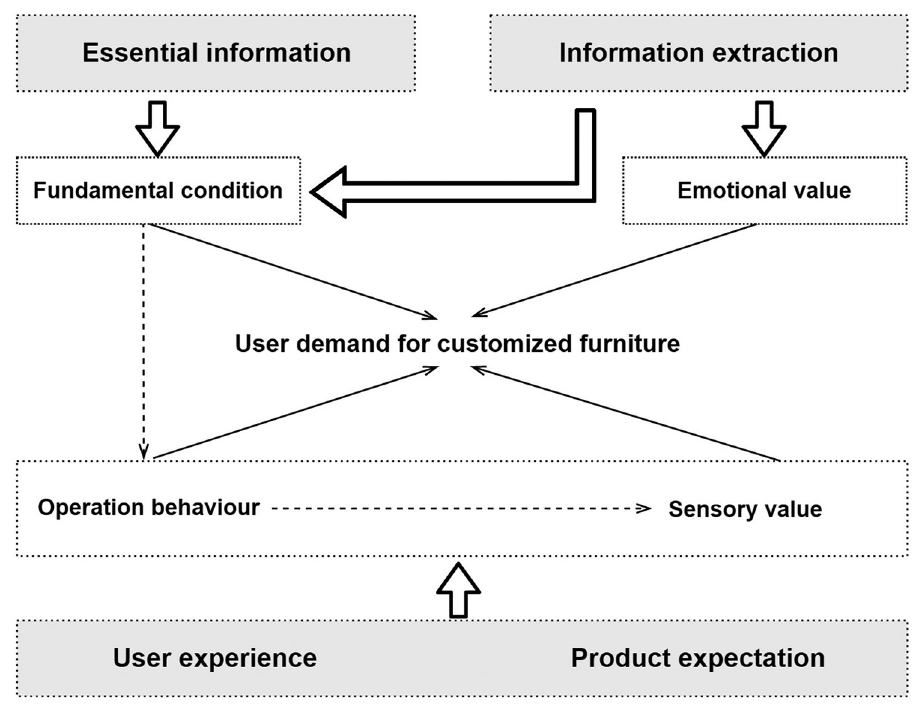
Fig 3. Demand factors for customized